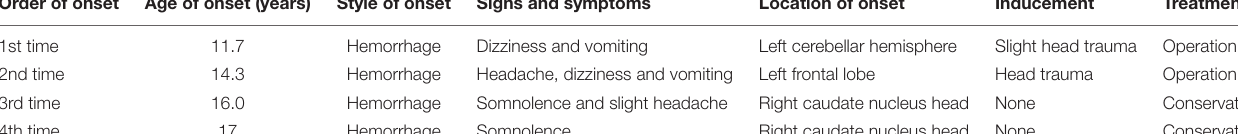
TABLE 1 | The proband’s detailed conditions for the four times.